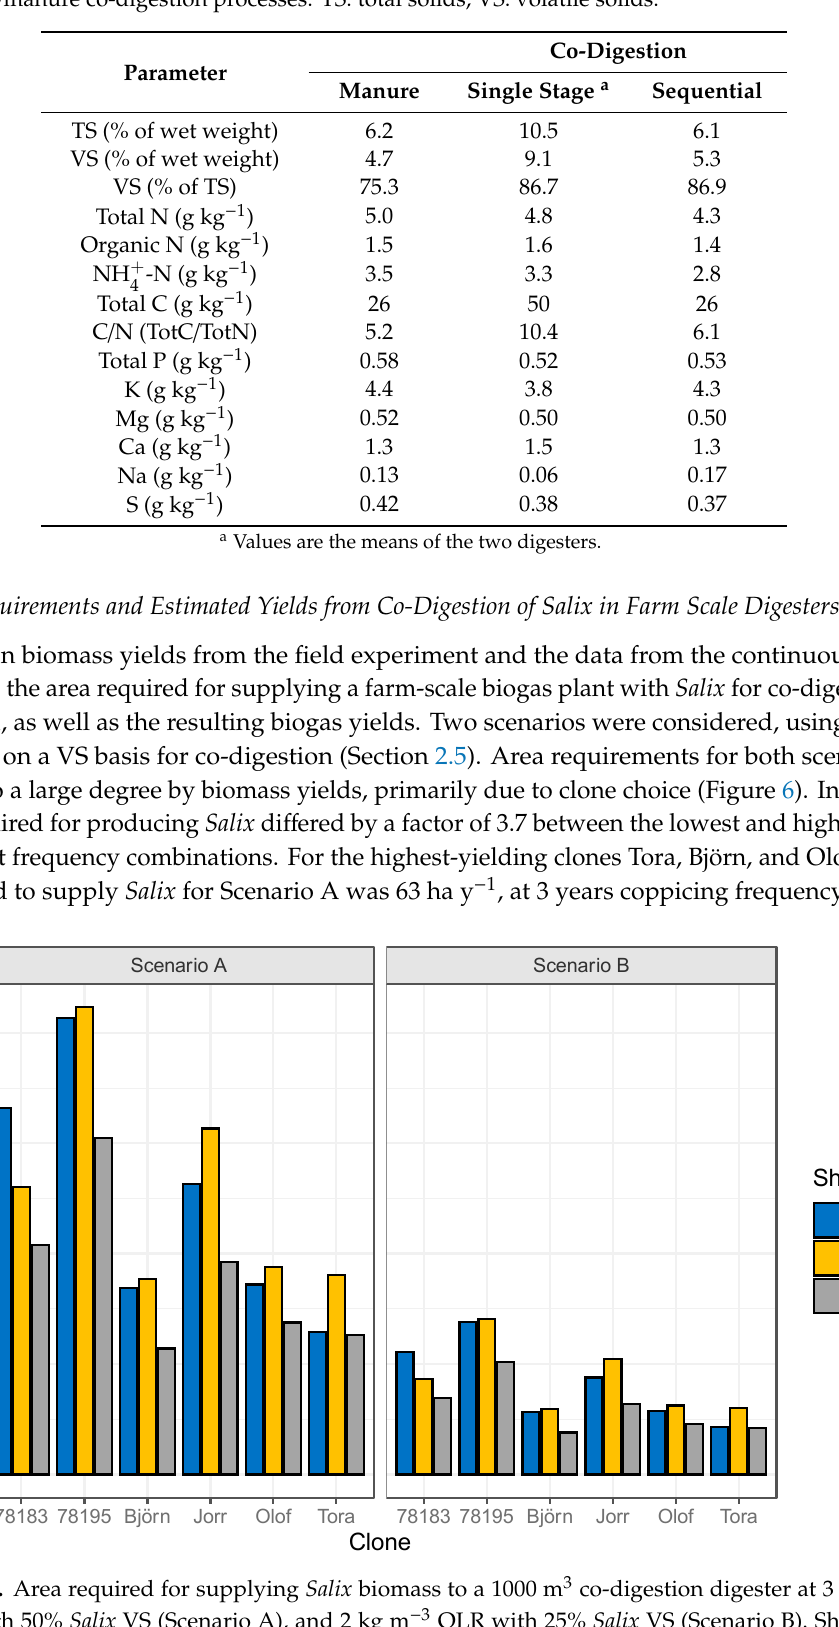
Table 4. Compositional analysis of digestates originating from a pure manure digestion process and the Salix / manure co-digestion processes. TS: total solids; VS: volatile solids.